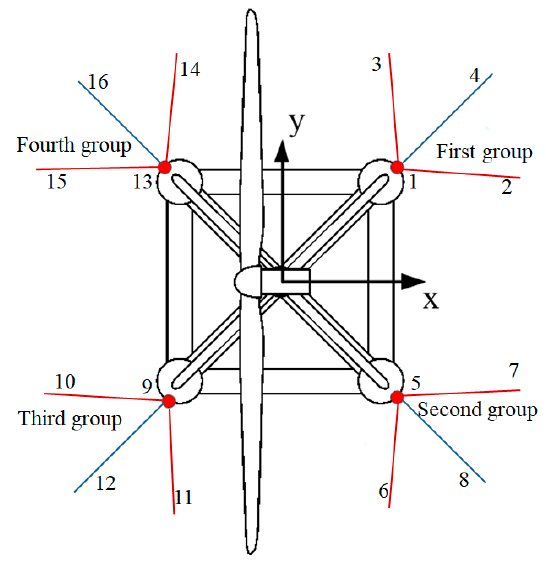
Figure 9. Safety factor of mooring lines under different mooring configurations.